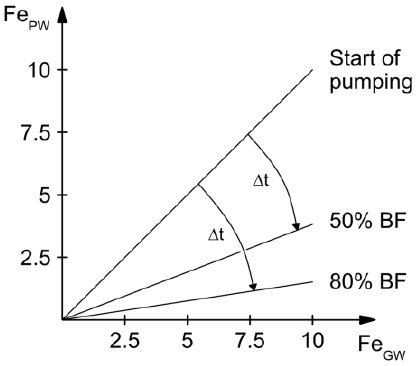
Figure 5. Case B – Significant decrease in iron conc. in in pumped water after years or decades.